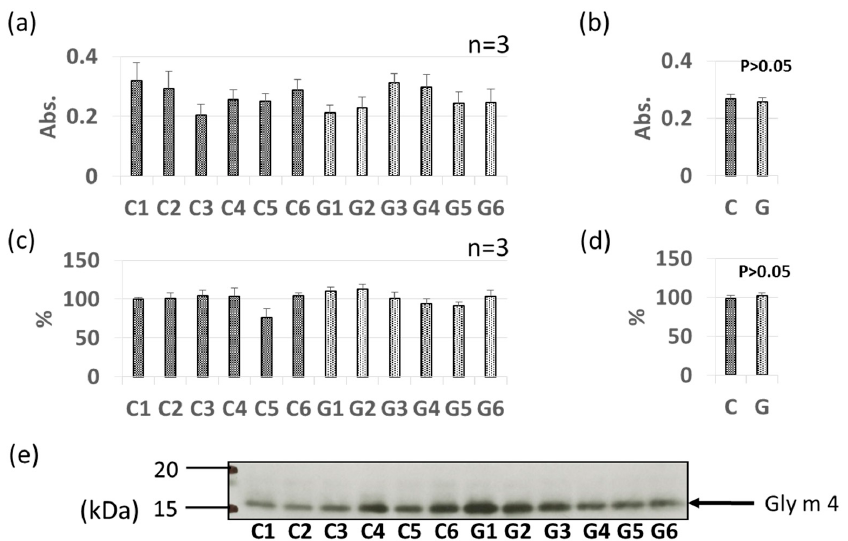
Figure 3. Comparison of Gly m 4 levels in GM-and non-GM soybeans by ELISA ( a , b ) and immunoblotting ( c – e ) using rabbit-derived polyclonal antibodies. Soybean protein extracts were evaluated by ELISA ( a , b ) and immunoblotting ( c – e ) for detection of Gly m 4 levels. The ELISA data are presented in absorbance values (Abs). The individual data from six GM-and non-GM soybeans ( a , c ) are presented as the mean ± SD of three independent replicates. The collated data ( b , d ) are presented as the mean ± SD of all individual data points from the control (C1–C6, six non-GM soybeans) or experimental (G1–G6, six GM soybeans) groups relative to the value of control number 1 (C1). A representative immunoblot is also provided ( e